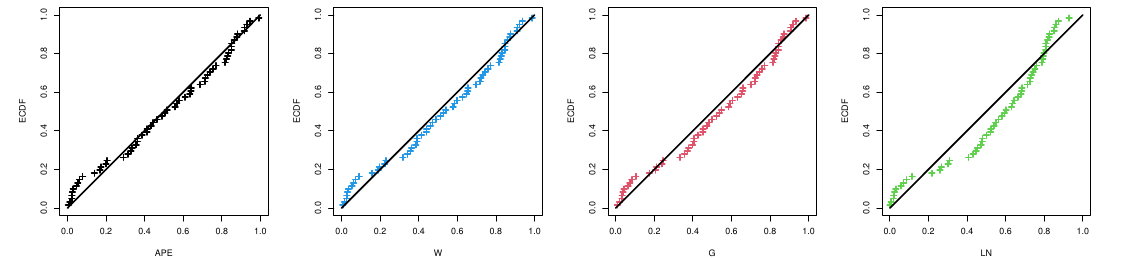
Figure 5. The quantile–quantile plot of the APE distribution and other competing models from electrical appliances data.